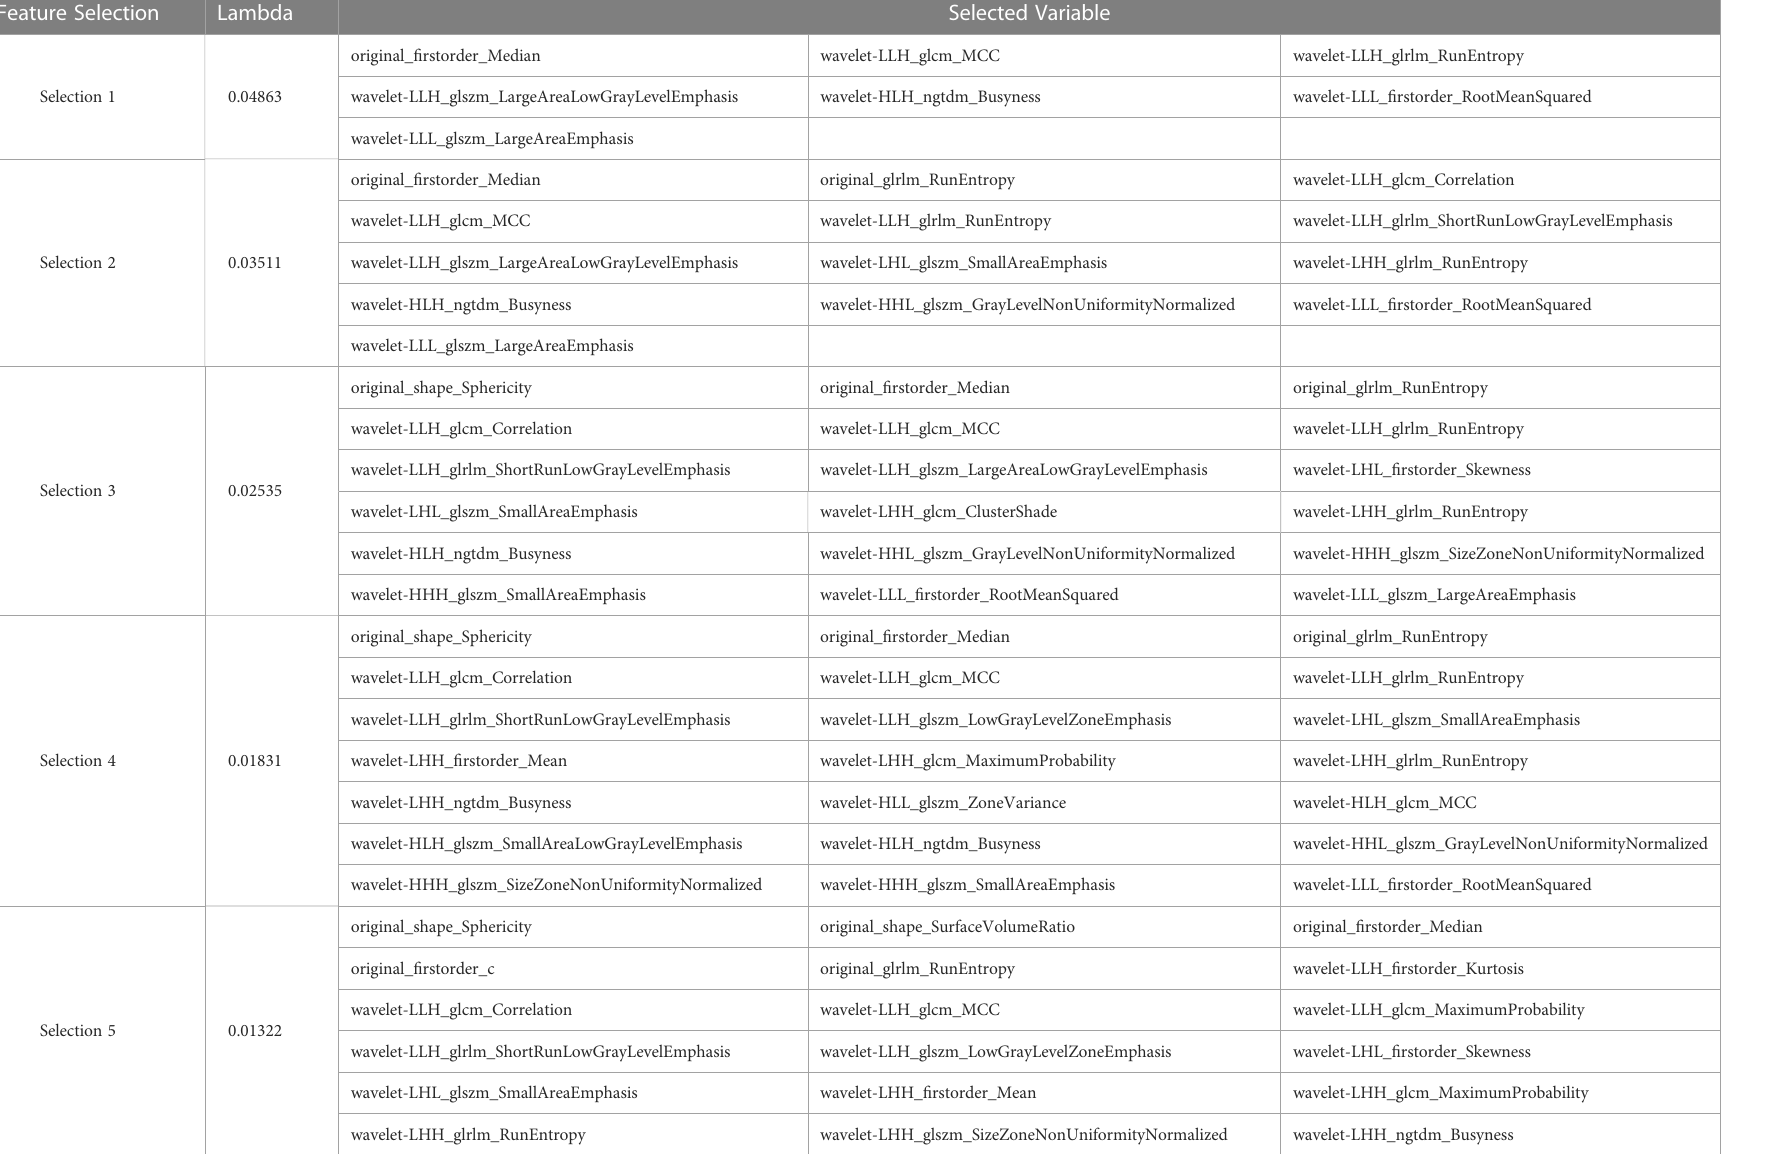
TABLE 2 Top fi ve variable feature selection performed by LASSO Logistic Regression at various lambda value using